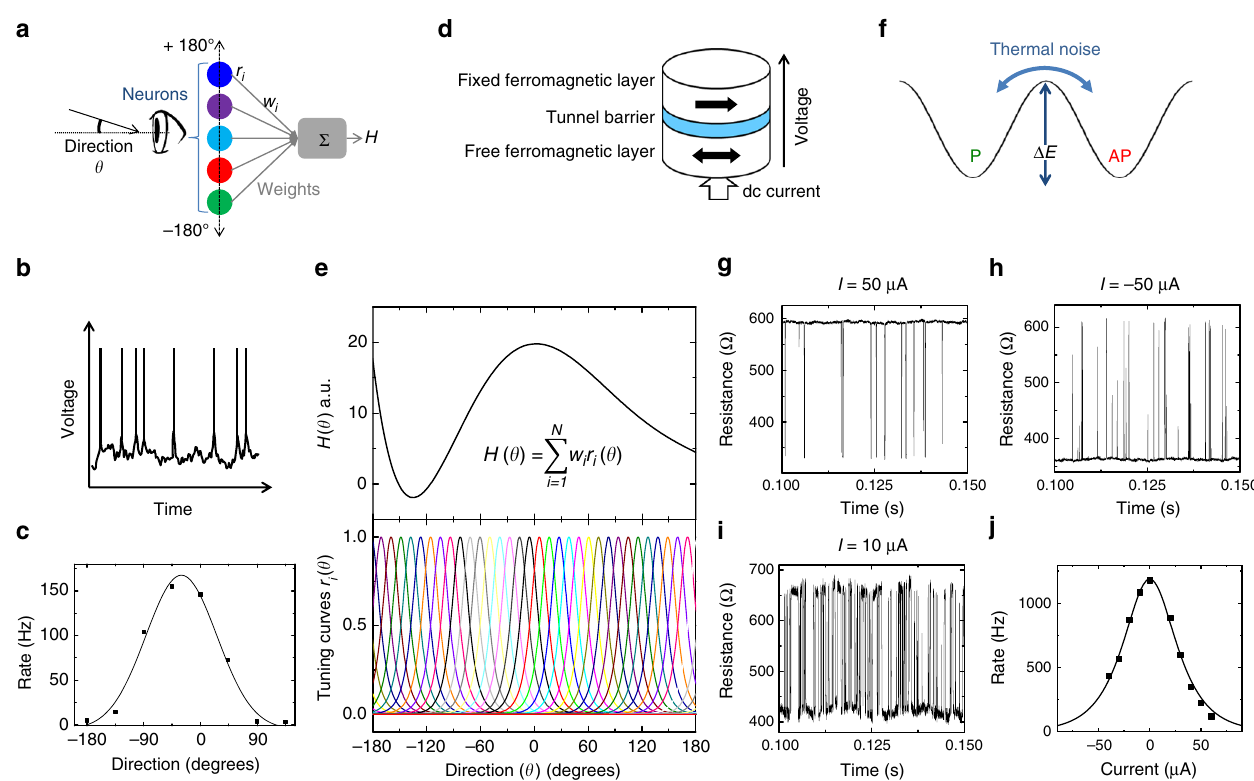
Fig. 1 Neural and superparamagnetic tuning curves for population coding. a Schematic representing information reconstruction from a population of neurons. Each neuron (color dots) senses a speci fi c range of stimuli (orientations). The represented function H is computed as a weighted sum of the rates of each neuron. b Sketch of a typical neuron fi ring pattern. The emitted voltage is plotted versus time. c Tuning curve of a neuron: spiking rate versus direction of the observed target, reproduced with data from 18 . Experiment (symbols) and Gaussian fi t (solid lines) are shown. d Schematic of a superparamagnetic tunnel junction. e Polynomial function constructed from a weighted sum of the tuning curves of the population of neurons. f Energy landscape of the magnetic device. g – i Experimental measurements of the resistance versus time of a superparamagnetic tunnel junction for injected currents of 50 µ A ( g ), − 50 µ A ( h ), and − 10 µ A ( i ). j Rate of the superparamagnetic tunnel junction versus current. The experimental results (symbols)